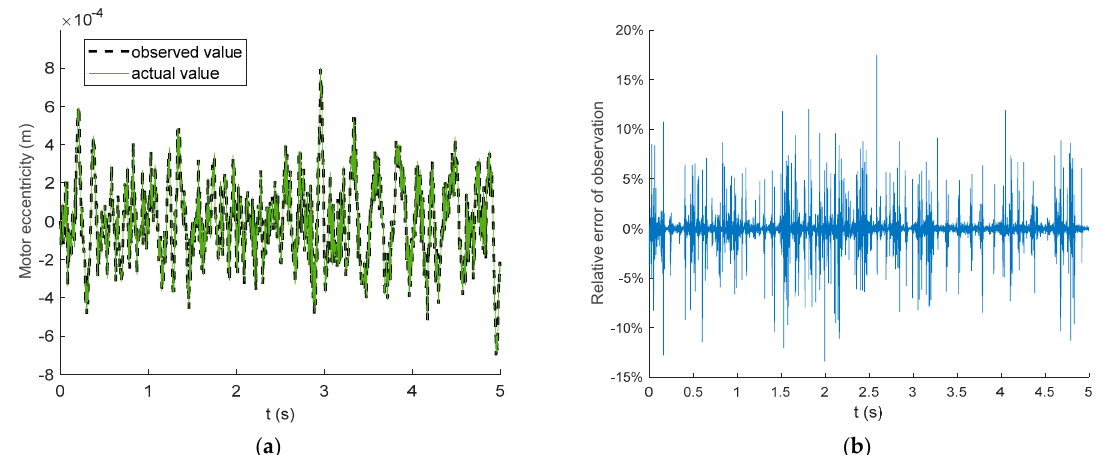
Figure 10. Observed results of motor stator eccentricity. ( a ) Comparison of observed and actual values. ( b ) Relative error between observed and actual values.